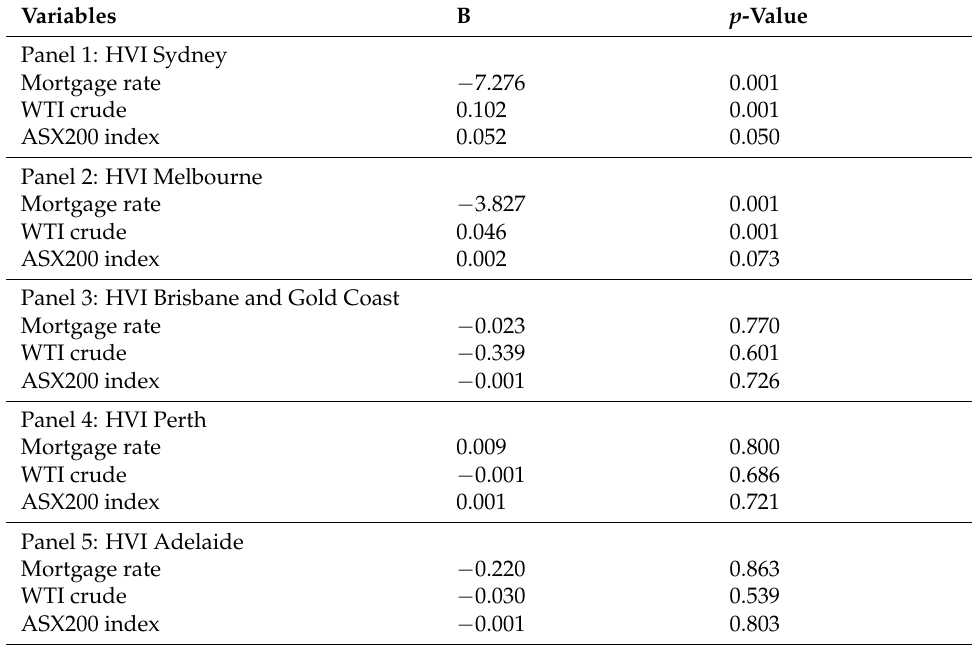
Table 2. Results of Bootstrap regression.